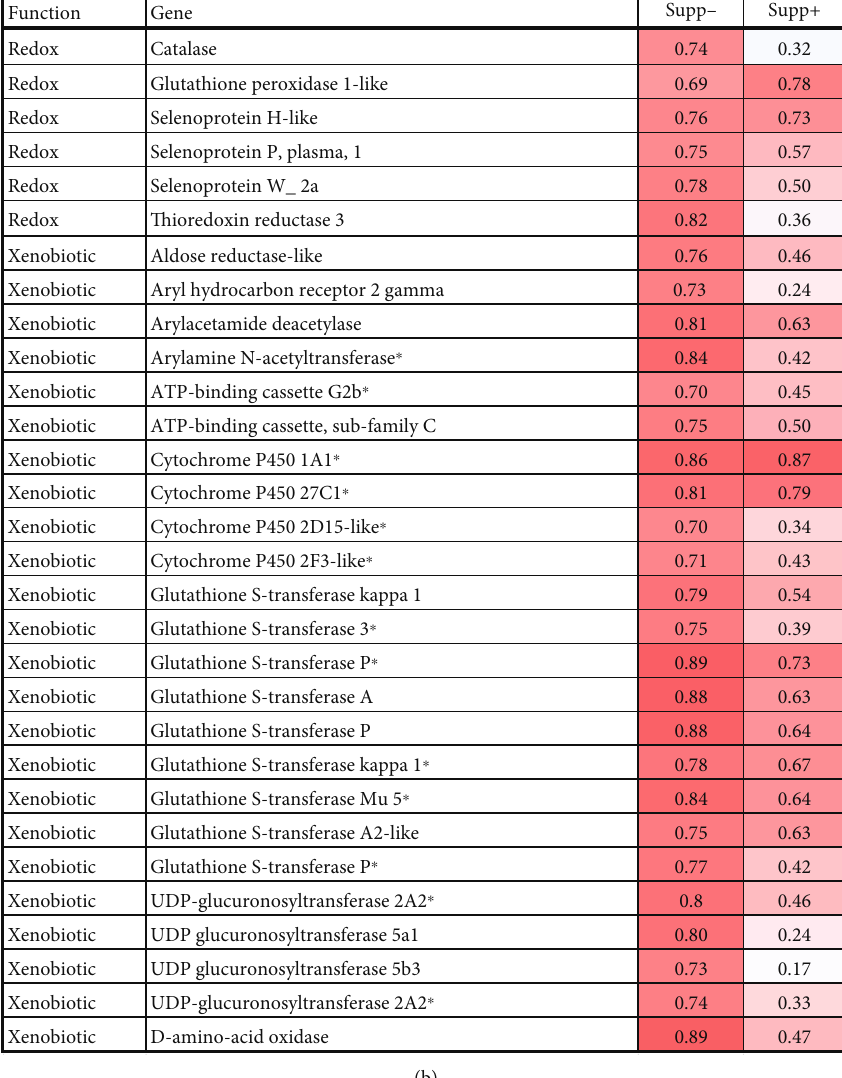
Figure 14: Correlation between FM levels and expression of genes encoding proteins with metabolic functions in the distal intestine. (a) lipids, retinol, steroids, iron, and heme. (b) metabolism of reactive oxygen species and biotransformation. Data are correlation (Pearson) with FM in feeds with and without supplements ( Supp − and Supp + ). Genes downregulated in the distal intestine with dietary enteritis (Kortner et al. [49]) are marked with ∗